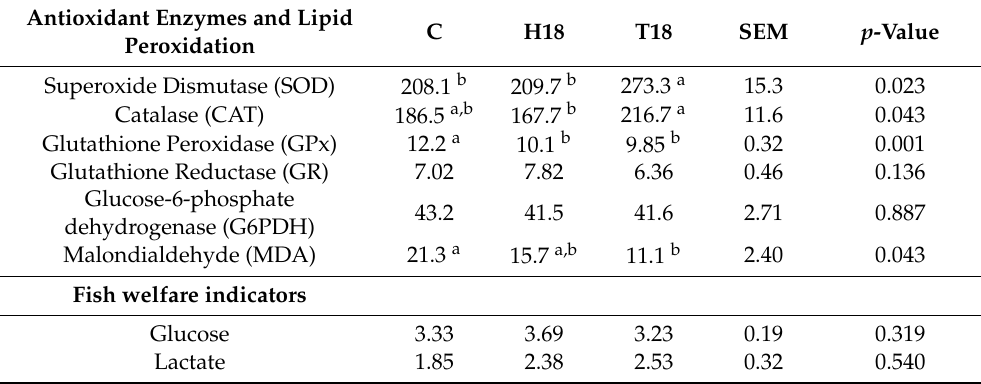
Table 7. Liver antioxidant performance and fish welfare plasmatic parameters of rainbow trout fed experimental